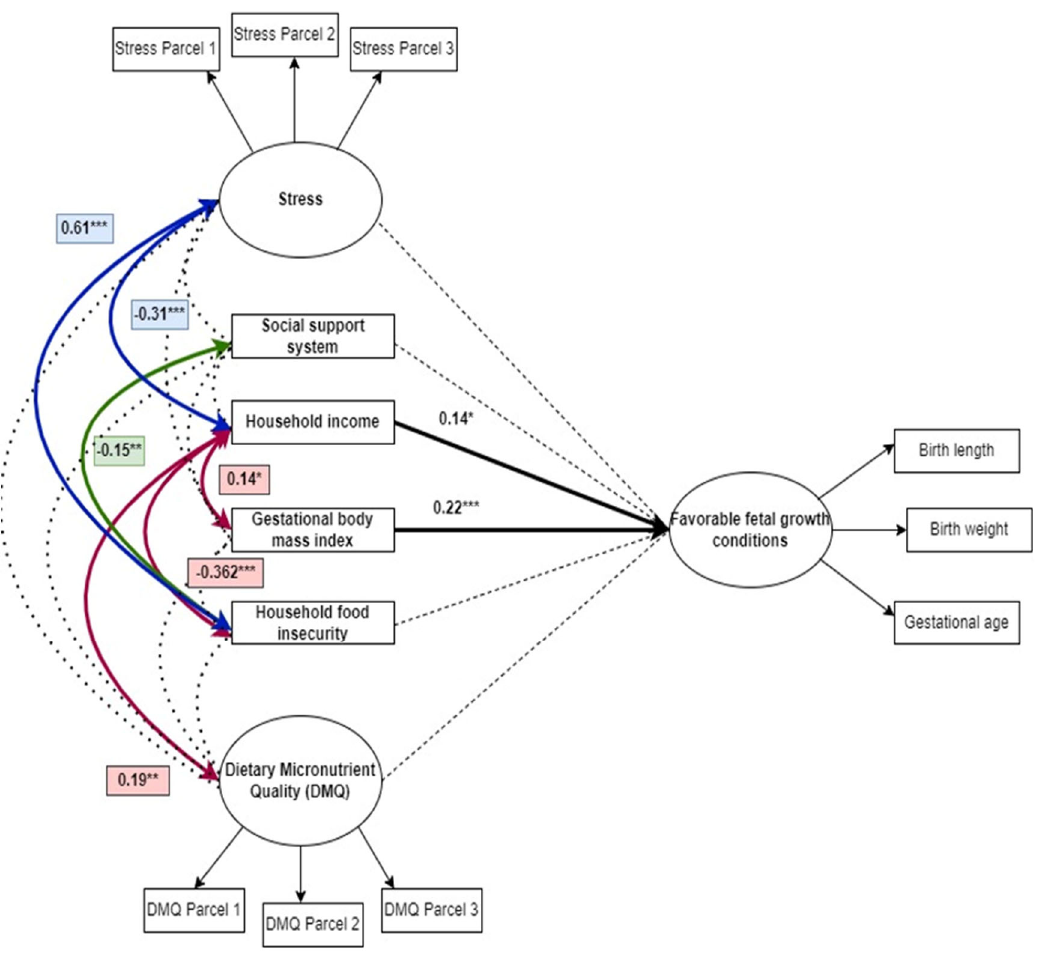
Figure 3. Final model of the nutritional and social determinants of favorable fetal growth conditions.